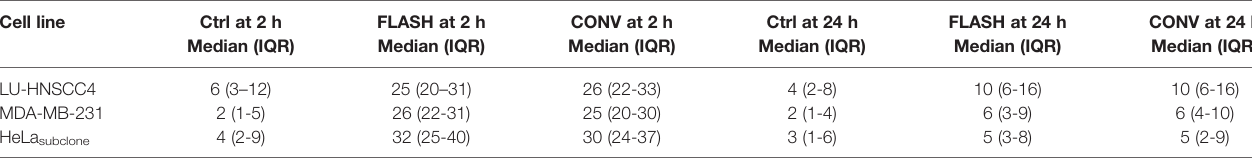
IQR, Inter-quartile range.